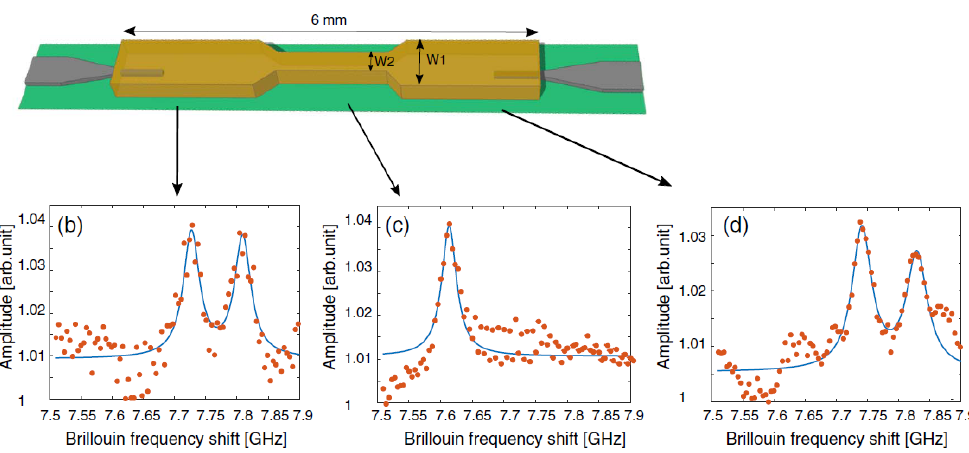
Figure 12. Detection of a 2-mm feature size in a silicon-chalcogenide platform [49] (reprinted from [49] with permission from